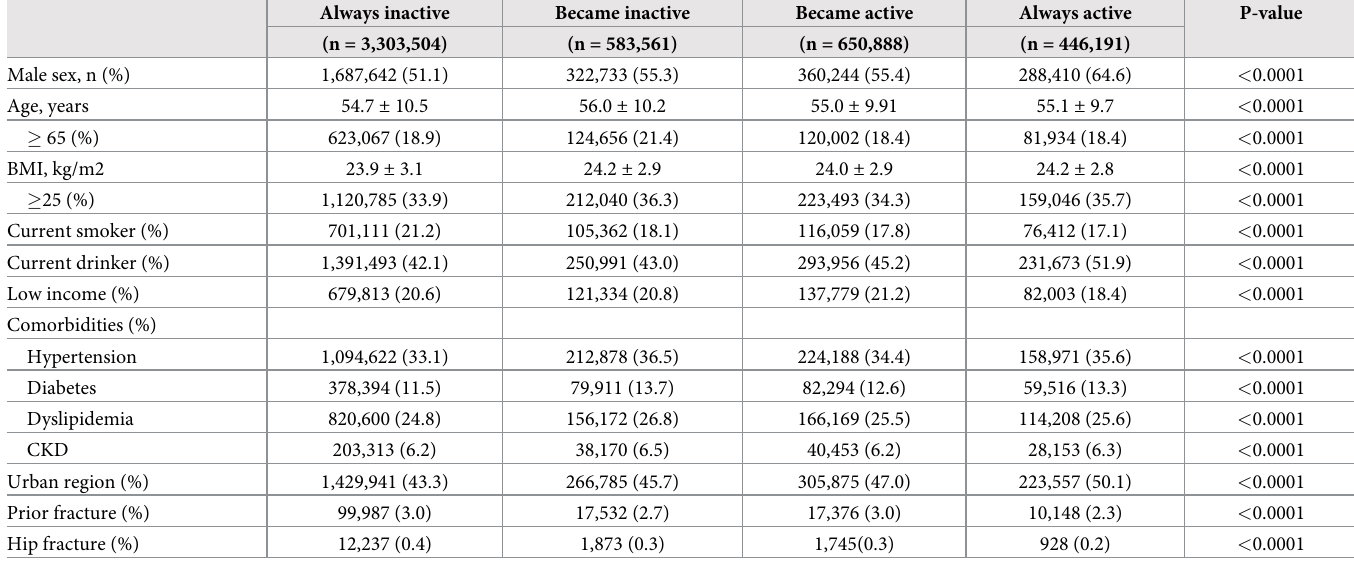
Table 1. Baseline characteristics stratified by change in regular physical activity. Always inactive Became inactive Became active Always